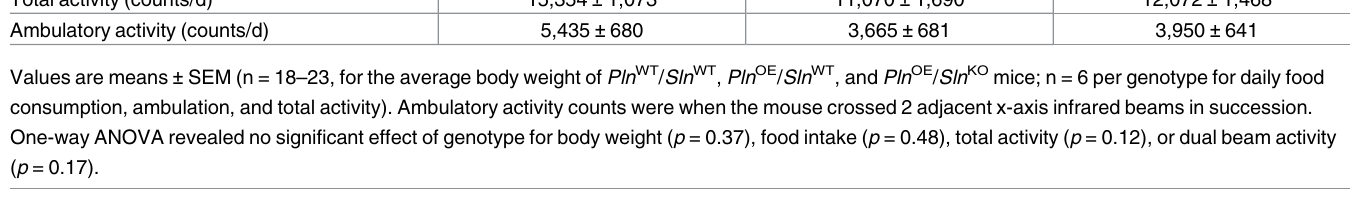
Table 1. Body weight, daily activity and daily food intake measuresfrom WT, Pln OE , and Pln OE / Sln KO mice. Parameter